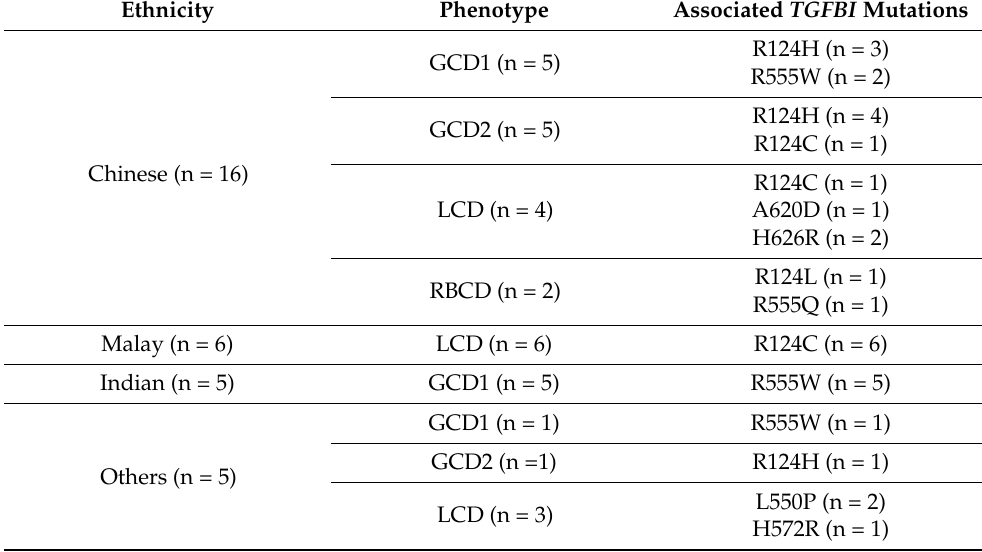
Table 3. Phenotypes and genotypes of TGFBI corneal dystrophy in various